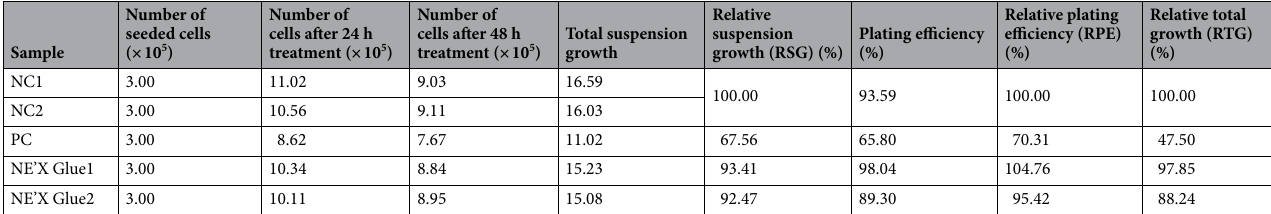
Table 6. Toxicity data, 4 h exposure, without metabolic activation. PC positive control, NC negative control.